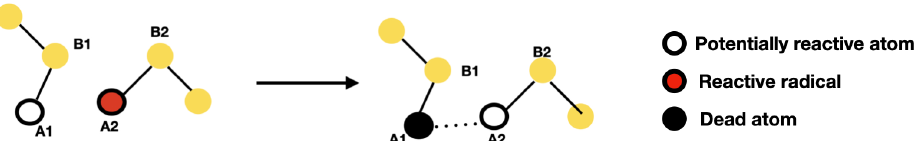
Figure 4. Illustration of the chain propagation reaction in the CG model. A new bond is created between the atoms A1, A2 if a reaction occurs (see text) and two angle potentials, B1-A1-A2 and A1-A2-B2, are added. In red, the reactive atoms; in white, the potentially reactive atoms; and in black, the inactive ones are